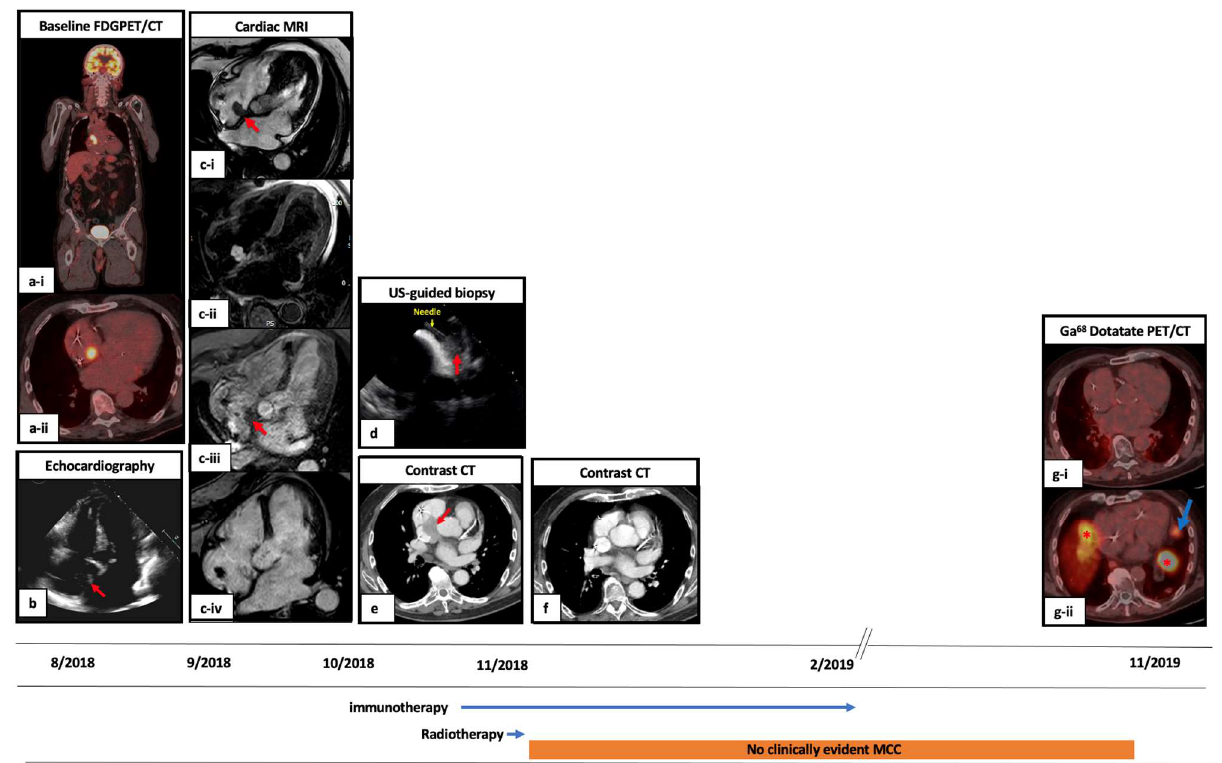
Figure 1. A case of patient with Merkel cell carcinoma of the buttock and oligo-metastasis to the heart. An 86-year-old immunocompetent man was initially diagnosed with a 10 cm Merkel cell carcinoma (MCC) of the left buttock. His baseline fluorodeoxyglucose/positron emission tomography/computed tomography (FDG PET/CT) for staging during the initial workup showed an incidental abnormal finding of a hypermetabolic mass in the right atrium (panel a-i ) and the intense FDG avidity on PET/CT made a myxoma less likely as the cause (panel a-ii ). The lesion was then evaluated by cardiac ultrasound (panel b ). On subsequent cardiac magnetic resonance imaging (MRI), there was an irregular mass in the right atrium that was attached to the interatrial septum and extended superiorly to the distal superior vena cava (panel c-i ). This mass demonstrated high signal intensity on the T2 black-blood sequence (panel c-ii ), weak perfusion on perfusion MRI (panel c-iii ), and late gadolinium enhancement on late postcontrast sequence (panel c-iv), which indicated that this did not represent a thrombus. The cardiac mass was biopsied under intracardiac echocardiography (panel d ) with pathology confirming metastatic MCC. The patient started first-line systemic therapy with avelumab followed by palliative radiation therapy to the primary MCC of the left buttock with 30 Gray (Gy) in 10 fractions and to the right atrium mass with 20 Gy in 8 fractions. Compared to contrast CT performed before RT (panel e ), a restaging CT scan performed 1 month after RT completion showed complete resolution of the right cardiac MCC mass (panel f ). His primary MCC disease on the buttock also had a complete response. He discontinued avelumab due to grade 3 immune-related pneumonitis 8 months after, without clinically apparent evidence of MCC. Unfortunately, approximately 6 months after avelumab discontinuation, he was found to have a new enhancing left pericardial lesion measuring 1.9 × 1.2 cm in size on contrast CT outside the radiation field. On a Gallium-68 (Ga 68 ) Dotatate PET/CT, there was no uptake in the initially treated right atrium (panel g-i ), but there was a new intense radiotracer uptake in the left pericardial lesion (blue arrow. Red * showed physiological uptakes) (panel g-ii ). He had a single 8 Gy fraction of radiation therapy to the new left pericardial mass, but the lesion progressed. Monthly somatostatin analog therapy was initiated but discontinued after 7 doses due to disease progression. The patient then switched to combination therapy with ipilimumab and nivolumab, but he passed away from non-MCC causes 6 months after initiating the combination immunotherapy. The red arrow shows the cardiac mMCC in the right atrium.